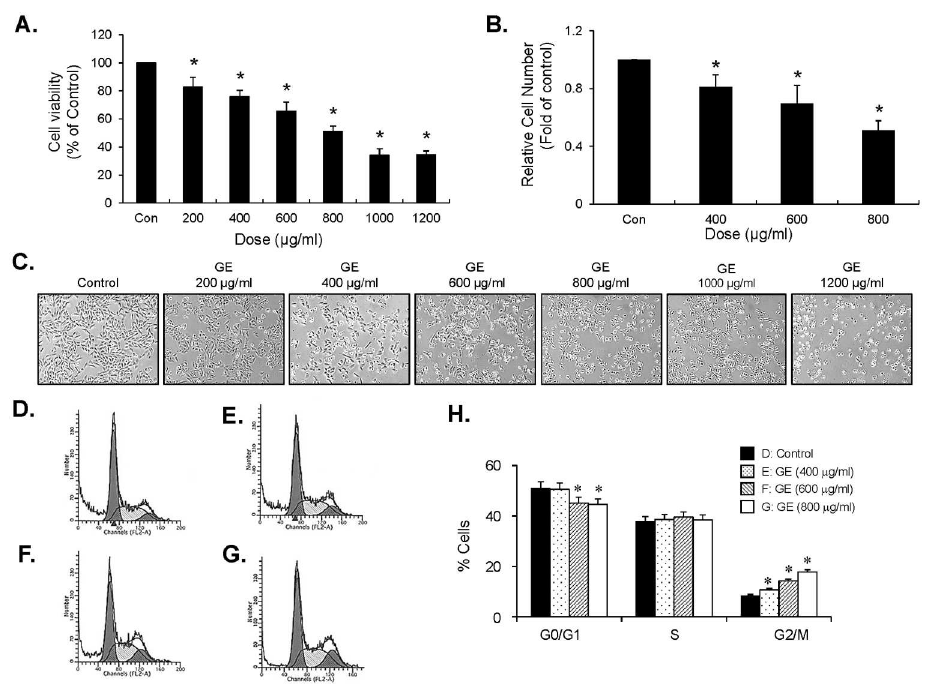
Fig 1. GE inhibited proliferation of EJ cells through blocking cell cycle progression at G 2 /M-phase. EJ cells were incubatedin culture medium with or without GE for 24 h. Cell viabilityand cell proliferation was measuredby both MTT (A) and viablecell counting assays (B). Results are representedas mean ± SE from three different triplicate experiments. (C) The morphologyof EJ cells under different concentrations of GE. Cellularimages were photographed by a phase contrast microscopy. (D-H) GE inducedcell-cyclearrest at G 2 /M-phase in EJ cells. Cell cycle distributionof EJ cells treated with different concentrations of GE was determined by flow cytometry. (H) Percentageof cells in each cell-cyclephase inducedby GE. Results in bar graphsare represented as mean ± SE from three different triplicate experiments. * P < 0.05compared with the